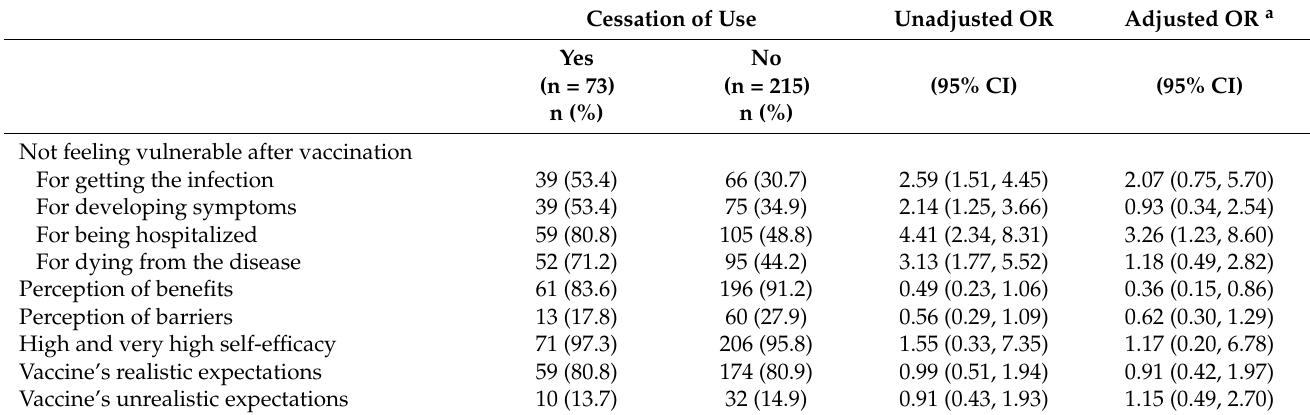
Table 2. Multivariate analysis of the vulnerability, benefits, barriers, self-efficacy, vaccine expecta- tions, and cessation of use of face masks.